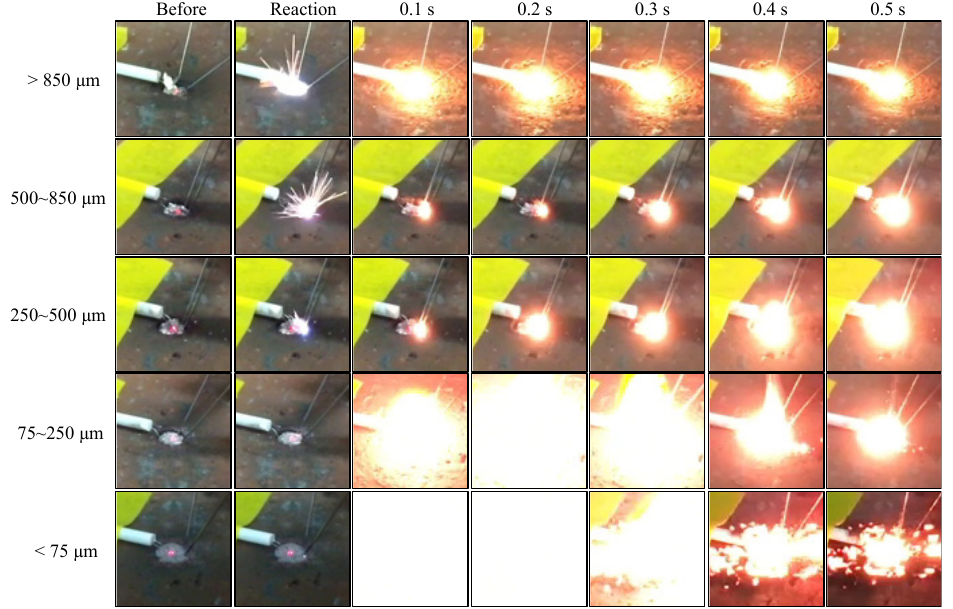
Figure 7. The exothermic reaction process recorded by the digital camera at the initiation stage up to 0.5 s at an interval of 0.1 s.